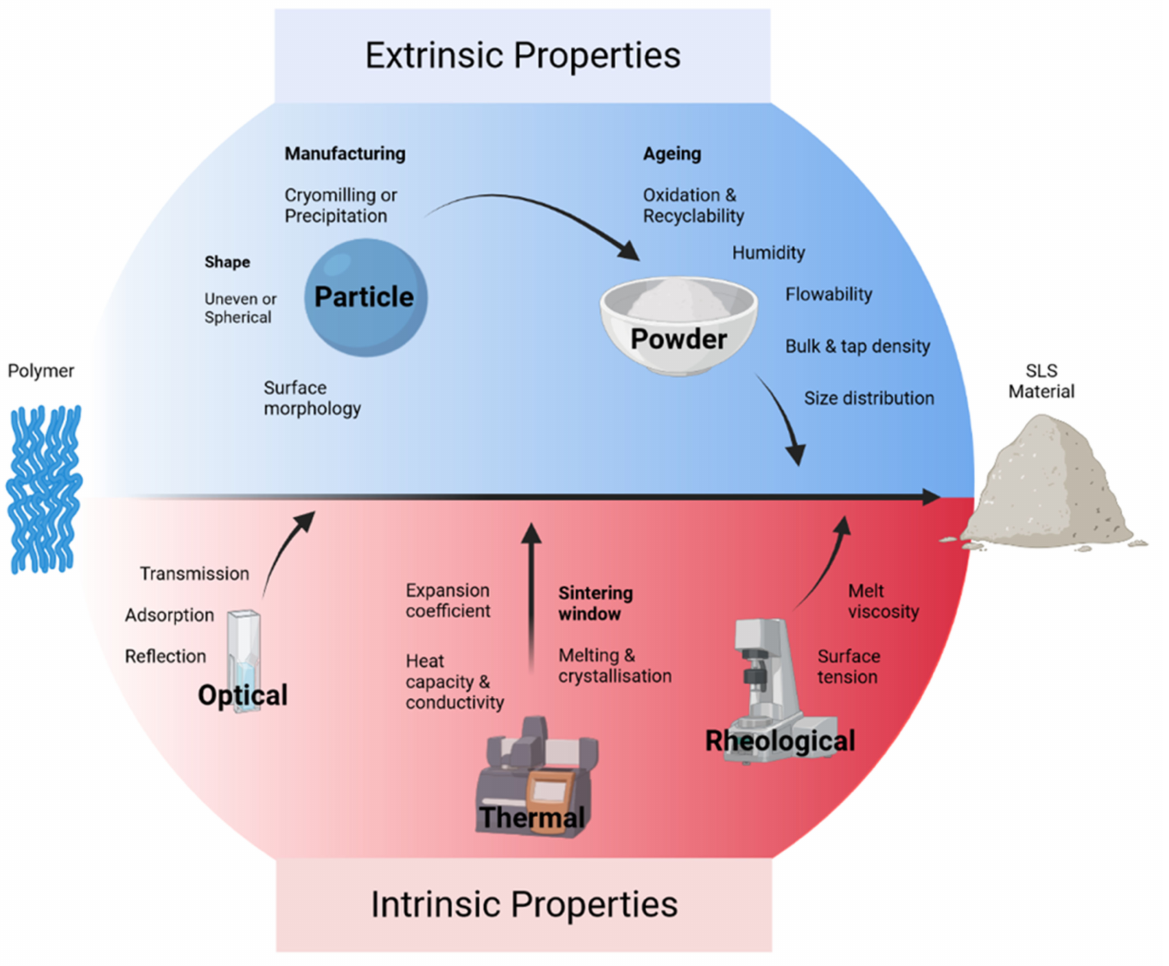
Figure 4. A summary of the extrinsic and intrinsic properties associated with the powder and process parameters that have an influence on materials used to produce parts via